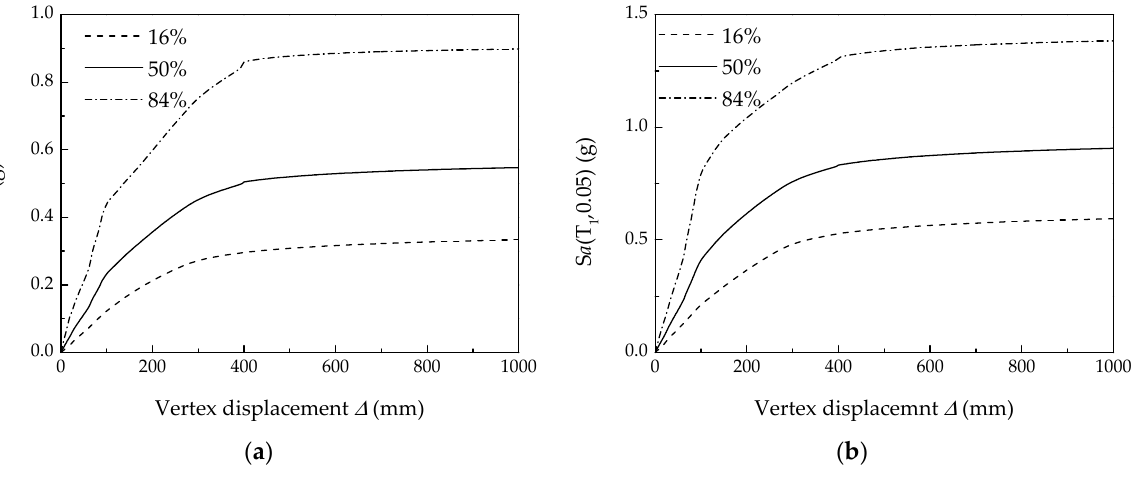
Figure 13. 50%, 16% and 84% quantile of the IDA curves of the RC frame. ( a ) PGA- ∆ quantile curves; ( b ) S a ( T 1 , 5%)- ∆ quantile curves.